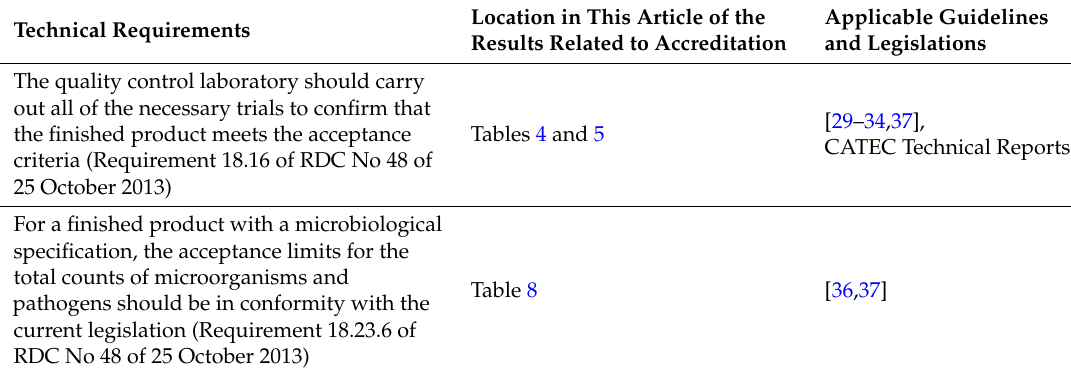
Table 3. Pertinent results for the manufacturing and storage phase of a cosmetic product.